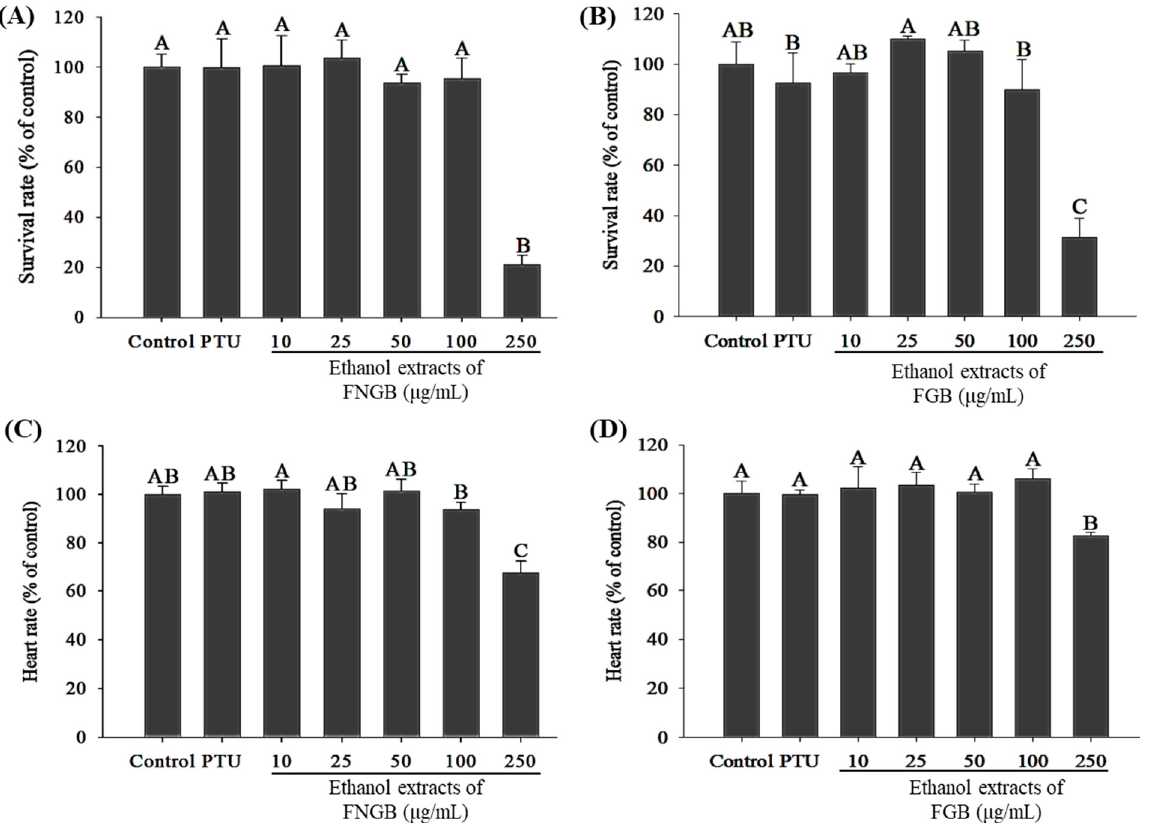
Figure 5. Effects of ethanol extracts from fermented-nongermination black soy milk and fermented-germination black soy milk on survival rate ( A , B ) and heart rate ( C , D ) in zebrafish embryos. Zebrafish embryos were treated with several concentrations’ ethanol extracts of fermented-nongermination black soy milk or fermented-germination black soy milk (10–250 µg/mL) from 7 to 55 hpf. The survival rate and heart rate were determined under an inverted microscope after 48 h treatment. The data are presented as means ± SD ( n = 3). Values with different uppercase letters were significantly by Duncan’s multiple range tests ( p < 0.05). PTU, 0.2 mM phenylthiourea; hpf, hours post